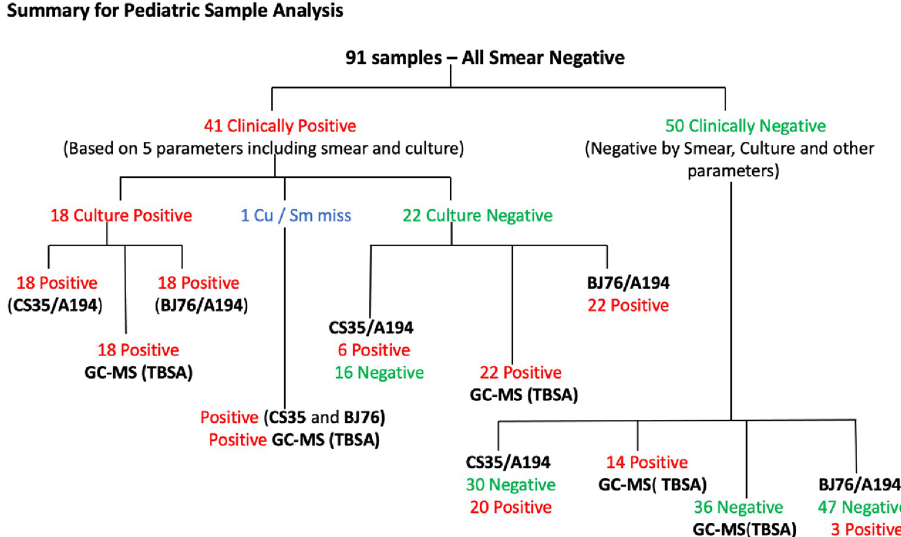
Fig 5. Summary of analysis of pediatric TB samples in this study. Flow chart for 91 pediatric TB samples showing clinically positive and negative status assigned by the clinicians with the patient samples diagnostic outcomes using C-ELISA and GC-MS to detect LAM in